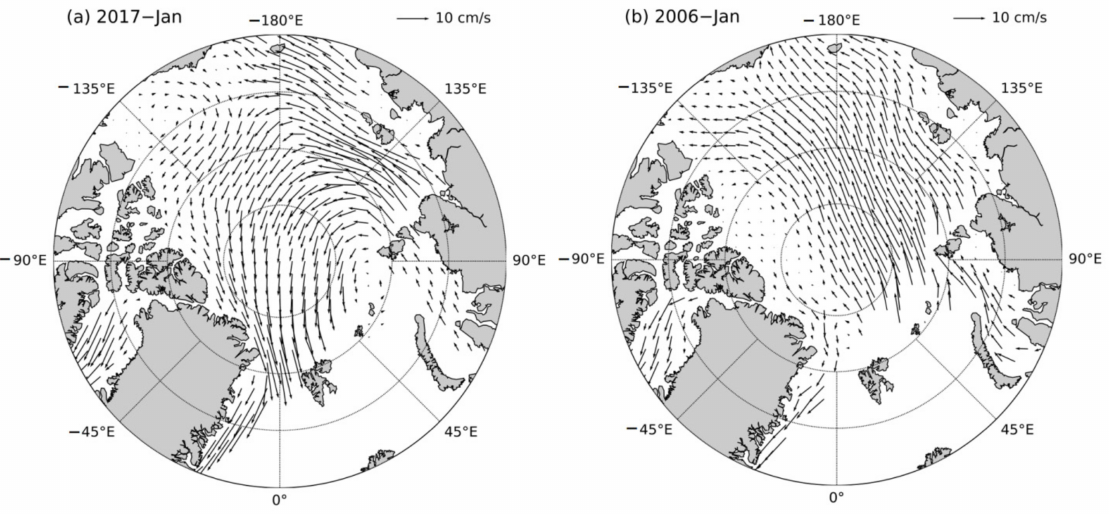
Figure 12. Monthly sea ice motion of ( a ) 2017 January (positive DA) and ( b ) 2006 January (negative